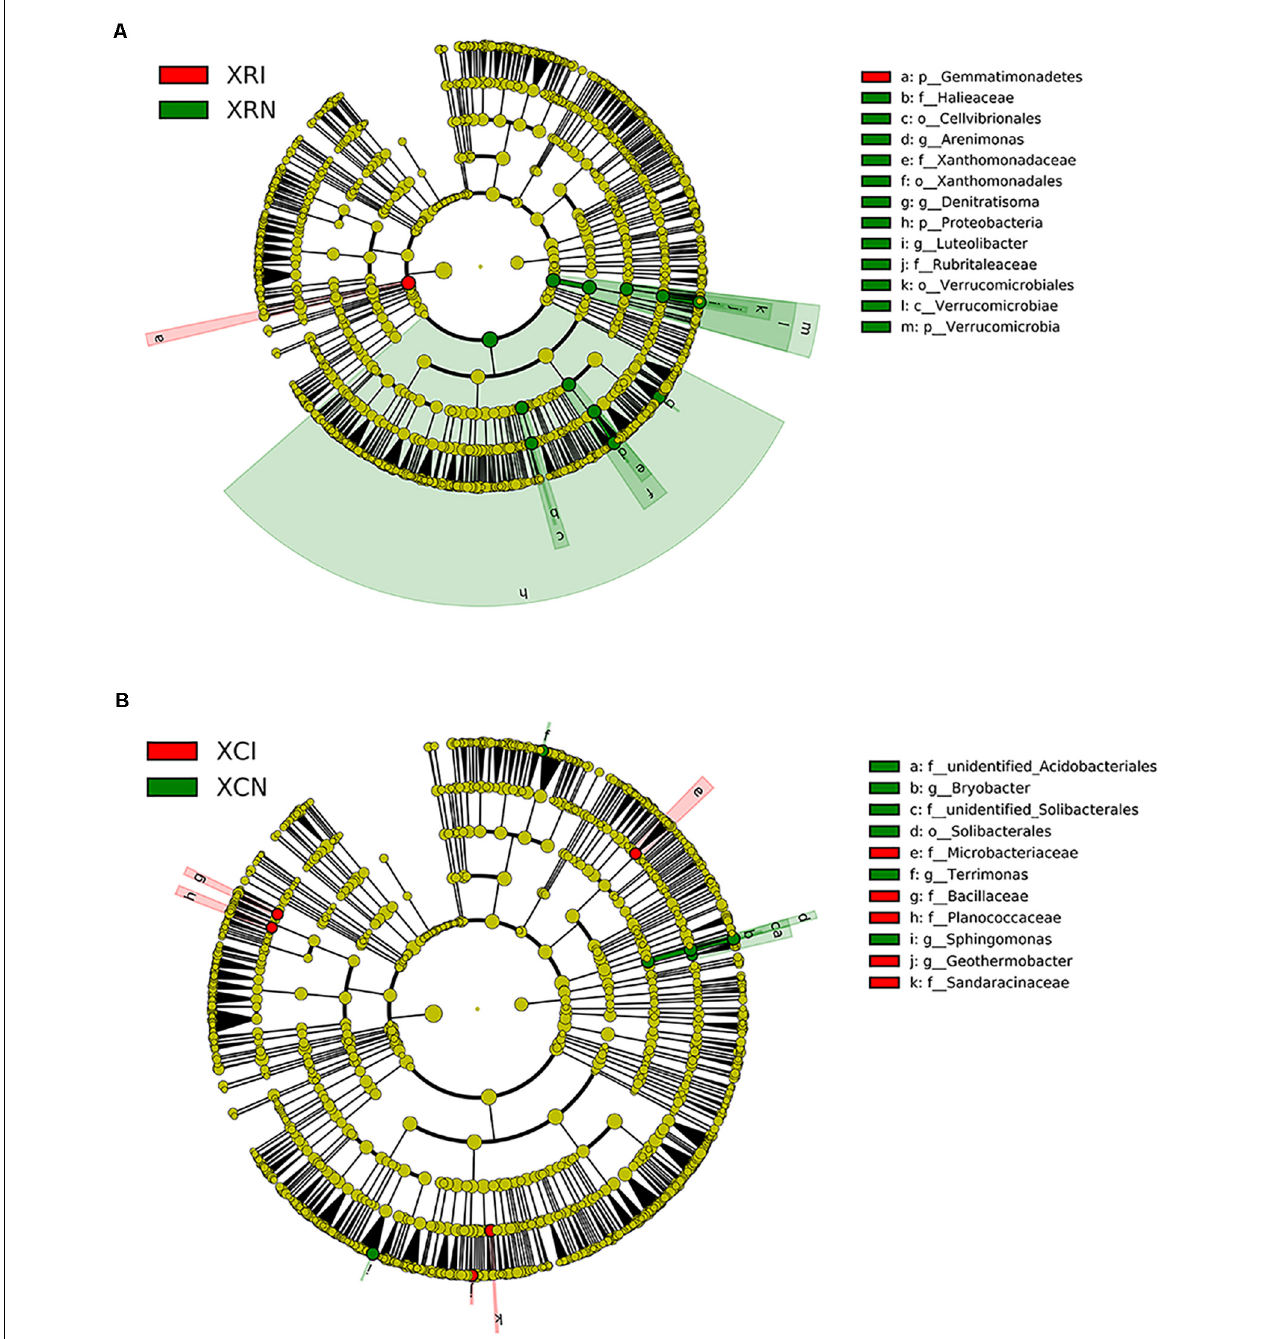
FIGURE 7 | The differences in microbial lineages between invaded sites and non-invaded sites analyzed by linear discriminant analysis effect size (LEfSe) in Xinxue River (A) and Xinxue River Constructed Wetland (B) . The cladogram shows the lineages with linear discriminant analysis score higher than 2.0. The different taxonomy units are represented by rings with different diameters. Yellow nodes show no significant difference in invaded sites and non-invaded sites, while red means the higher units in invaded sites and green means the higher units in non-invaded sites. XRI, Xinxue River invaded sites; XRN, Xinxue River non-invaded sites; XCI, Xinxue River Constructed Wetland invaded sites; XCN, Xinxue River Constructed Wetland non-invaded sites.